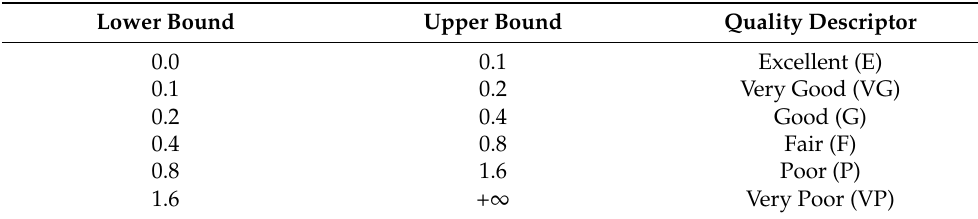
Table 1. Interpretation scale for GDM